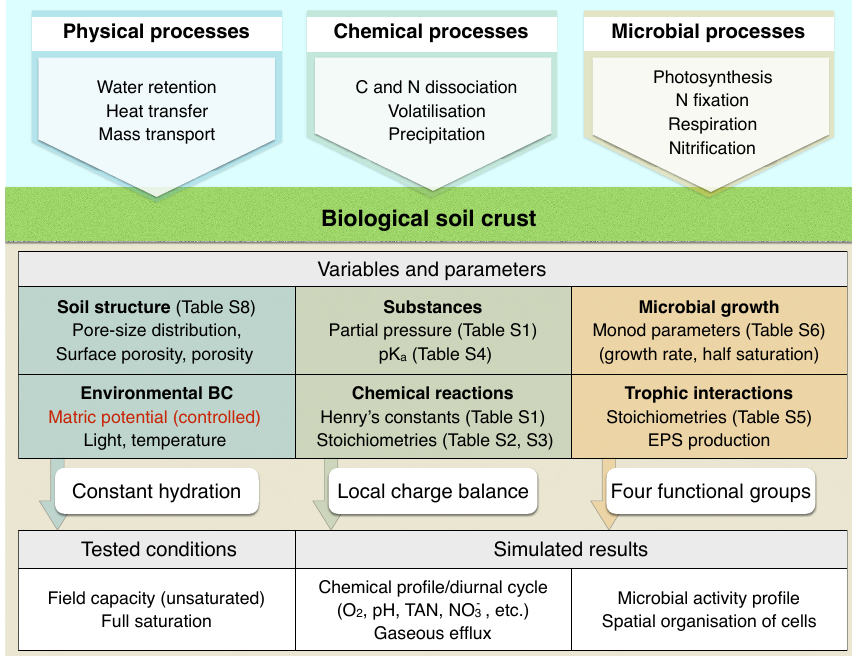
Figure 1. A summary of the desert biocrust model (DBM). The DBM includes various physical, chemical, and microbial processes occurring within biocrusts. Variables and parameters used in modelling are listed and the main assumptions for each process are summarised. In this work, we focused on how hydration conditions under diurnal cycles shape chemical and biological profiles within desert